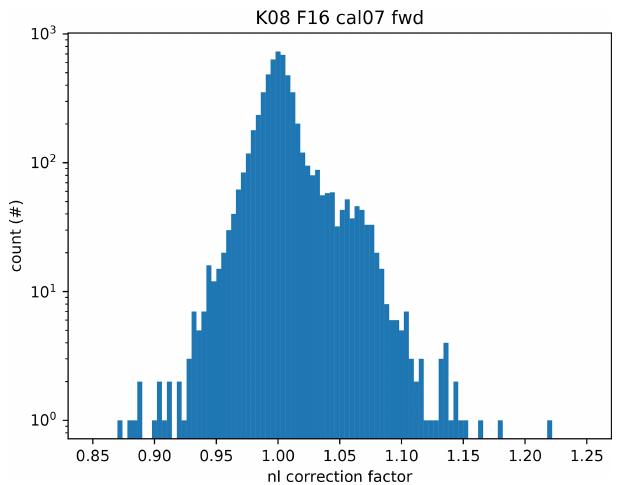
Figure 4. The frequencies of different nonlinearity correction fac- tors derived from one calibration sequence on a logarithmic